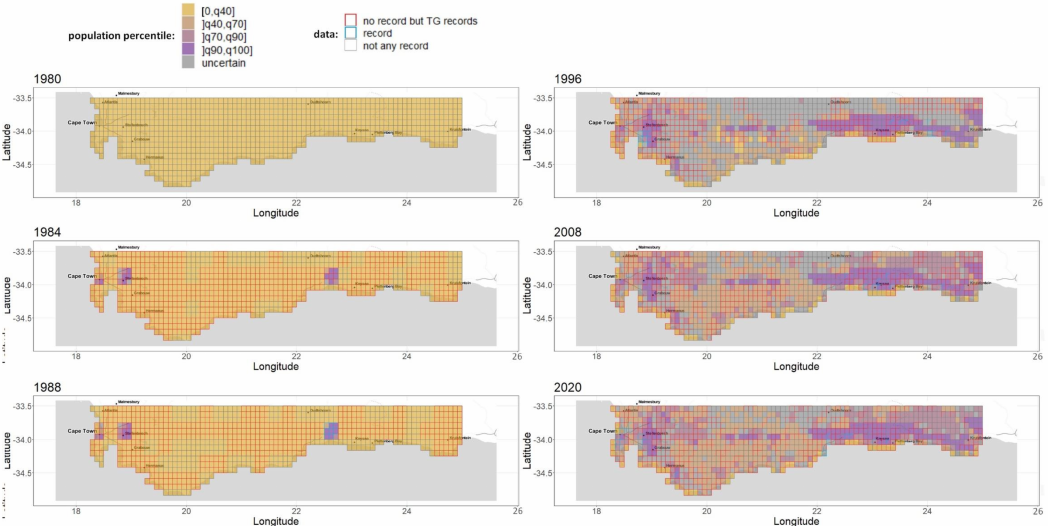
Figure 3. A reconstruction of Plectranthus barbatus invasion in the Southern Cape, South Africa, Part 1. Maps of population size percentile range for selected years between 1980 and